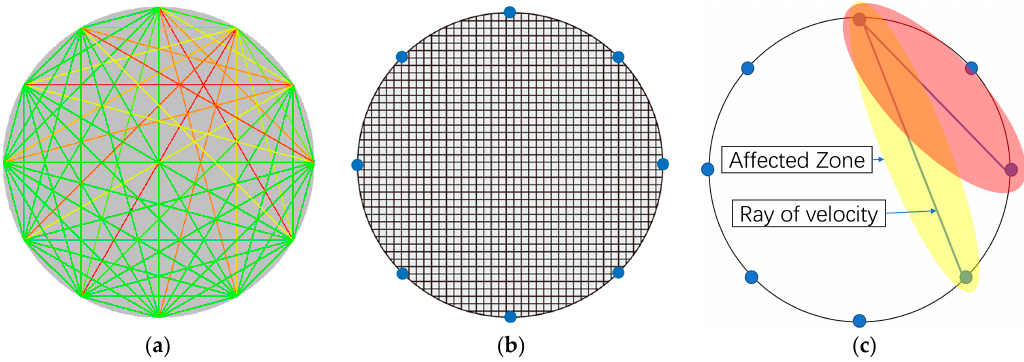
Figure 1. ( a ) An example of the rays graph; ( b ) Gridding of the imaging area; ( c ) Illustration of the EBSI (ellipse-based spatial interpolation) method.